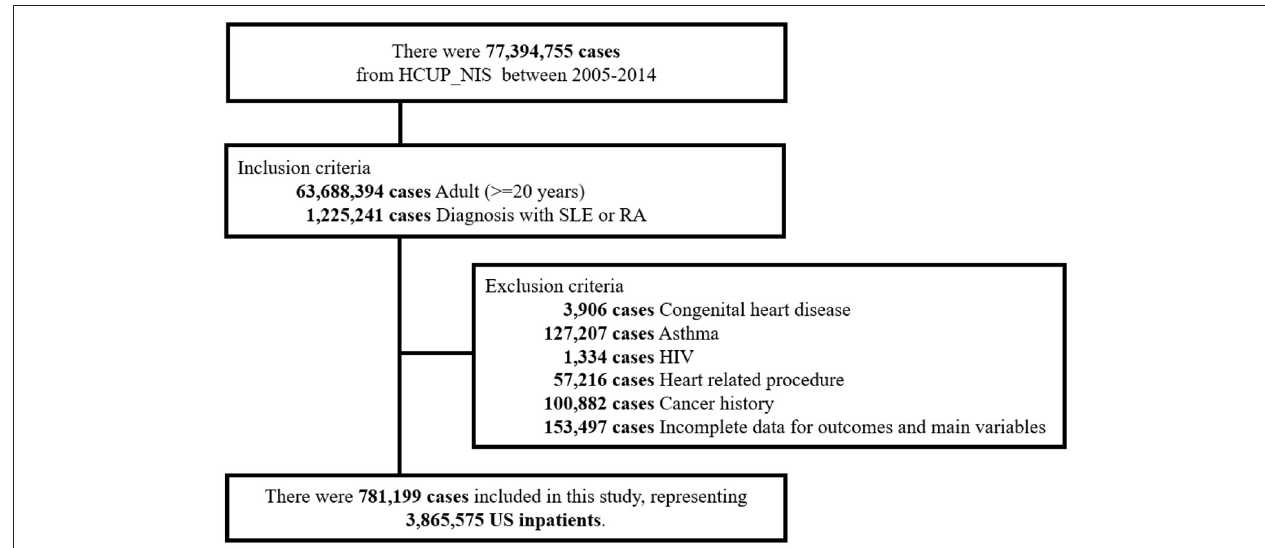
FIGURE 1 | Flow diagram of study